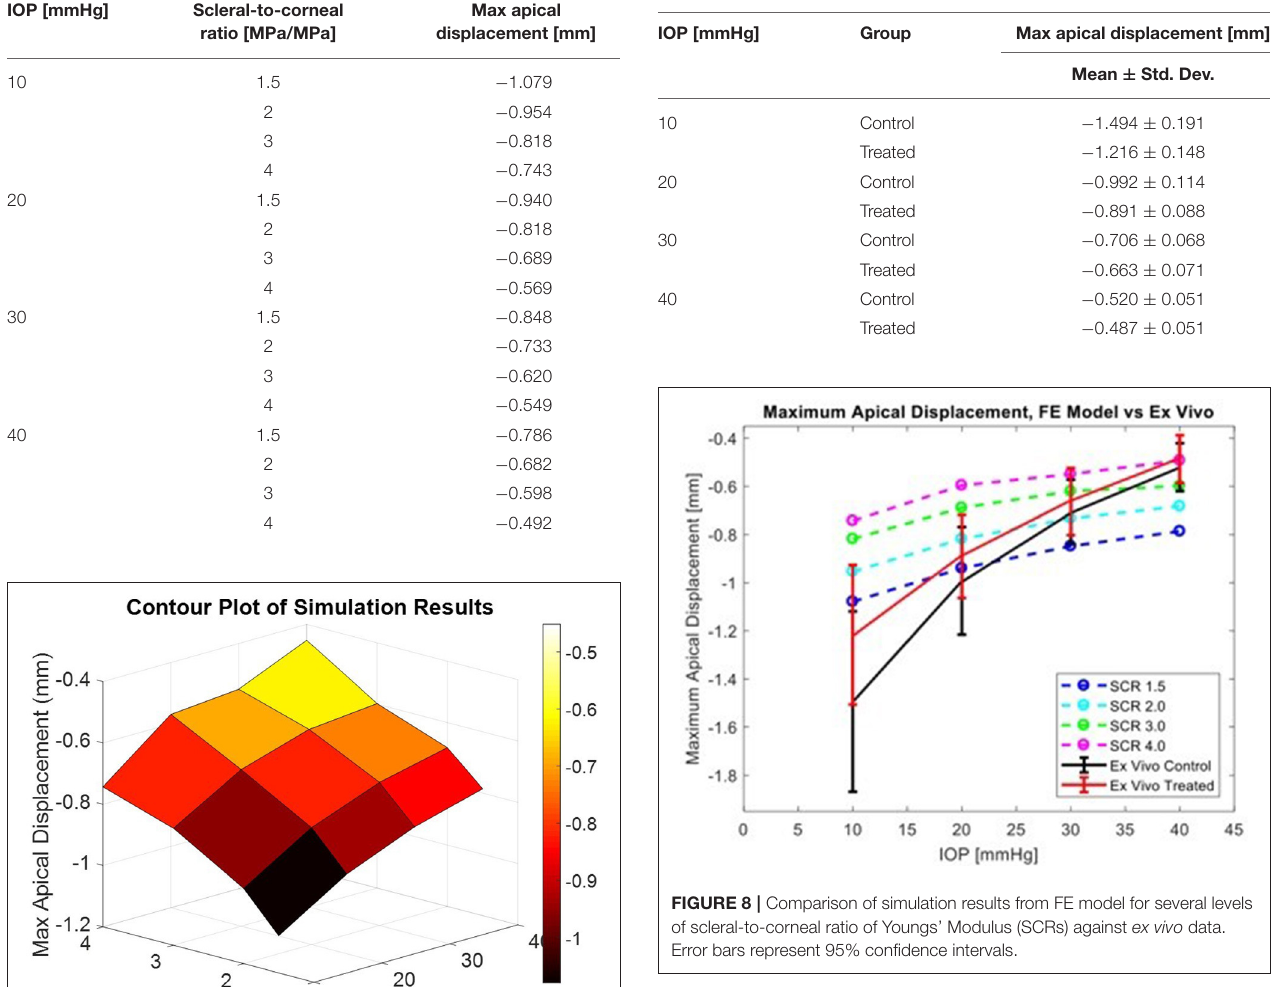
TABLE 7 | Summary of ex vivo results from human donor eyes (Nguyen et al., 2018).